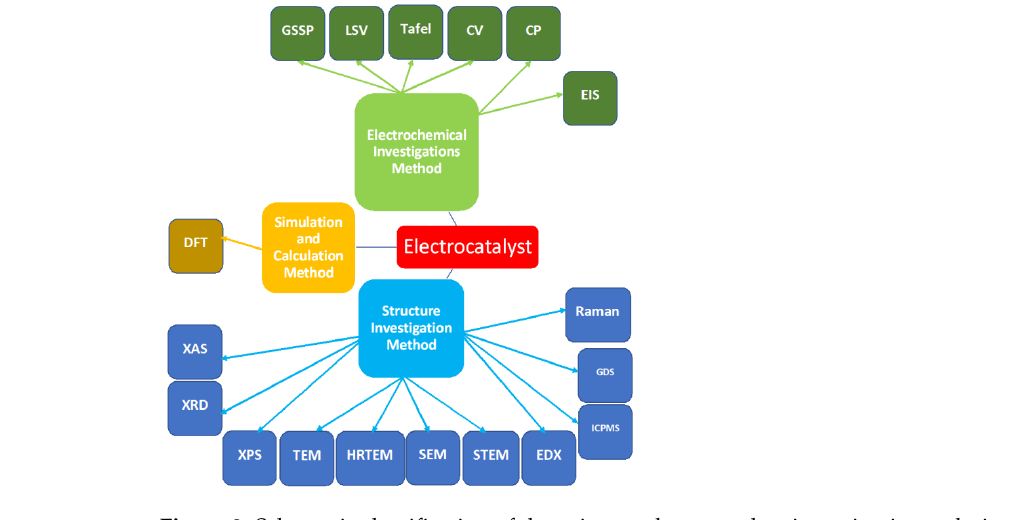
Figure 3. Schematic classification of the primary electrocatalyst investigation techniques utilized in the electrolysis of freshwater and seawater to produce hydrogen.